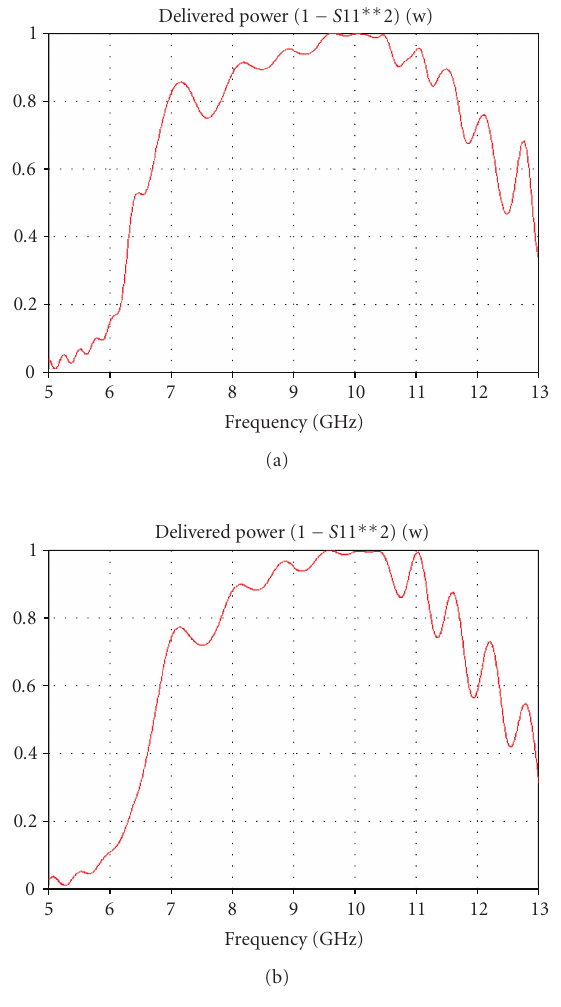
Figure 9: (a) Simulated e ffi ciency LWA Type II. (b) Simulated e ffi ciency LWA Type III.